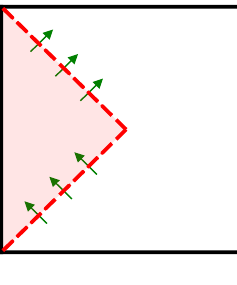
Figure 1 . The Penrose diagram of dS. We study in and out states in one static patch